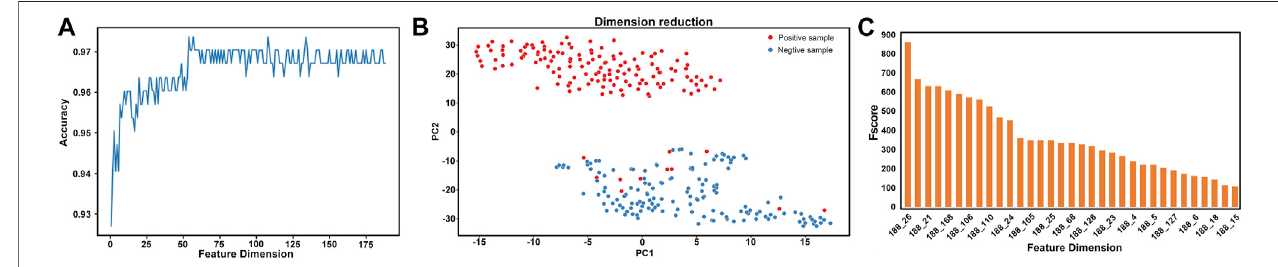
FIGURE3| Two-stepfeatureselectionresultdisplay (A) 10-foldCVandindependenttestaccuracyoftheRFclassi fi erwiththefeaturenumbervaried (B) dimension reductionresultsbasedonthePCAmethodfortheoriginaldatawithatotalof188dimensions (C) featurerankingoftheF-scoremethodobtainedbyANOVAforthedata with 188 features.